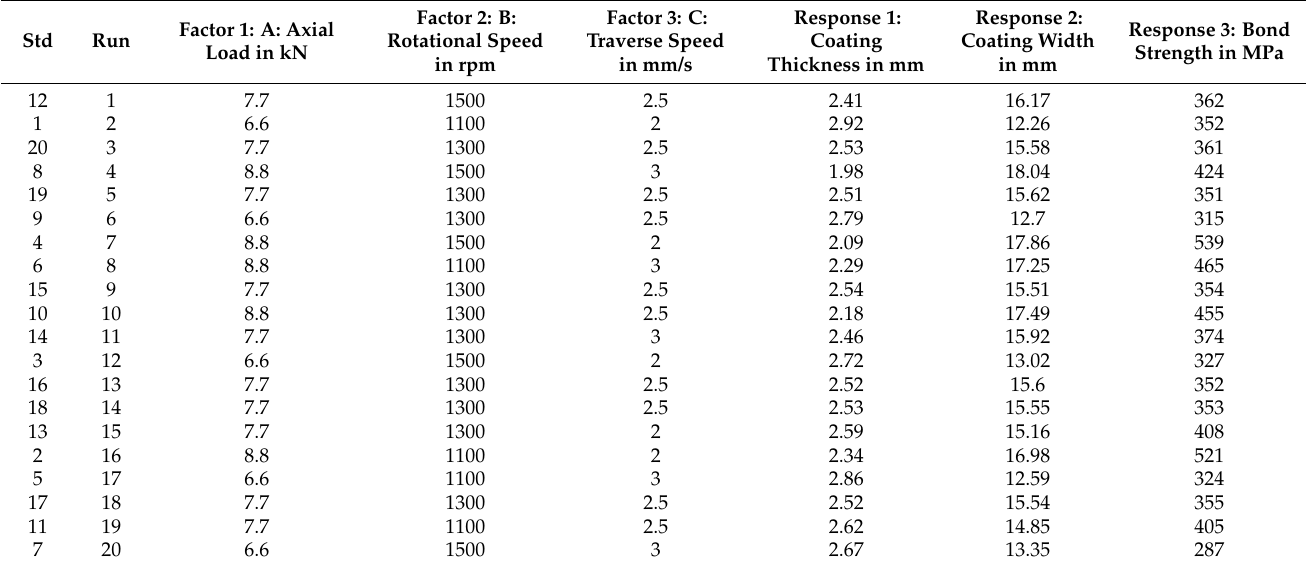
Table 4. Responses for the various parameter